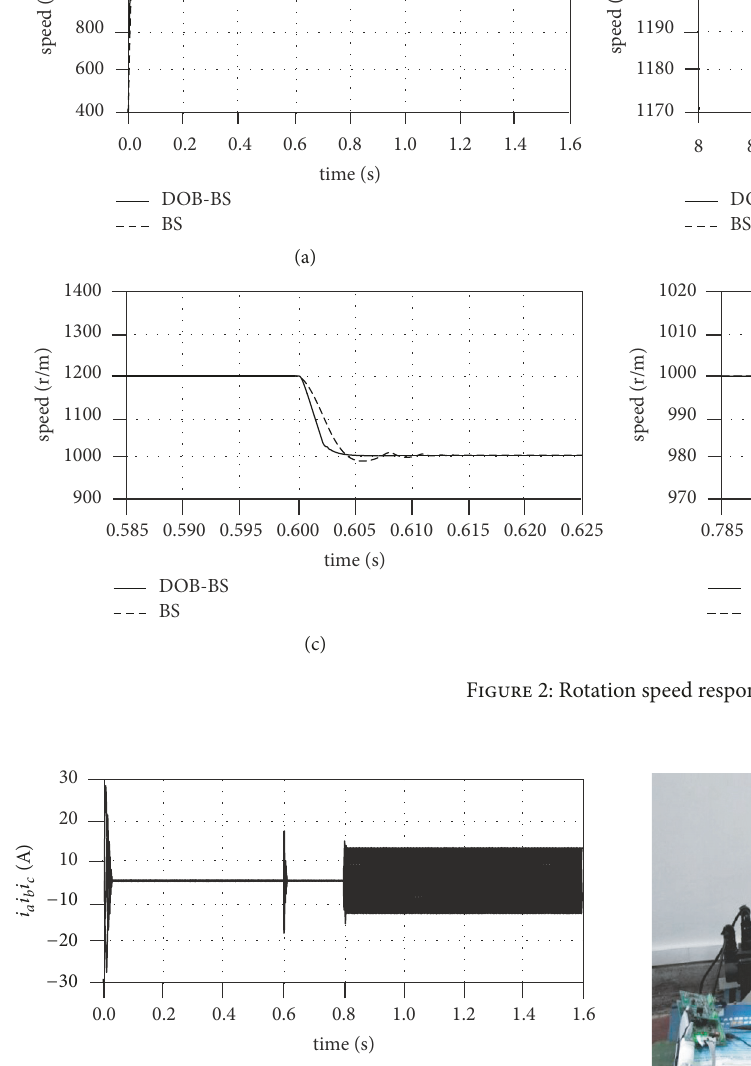
Figure 3: Three-phase stator current.